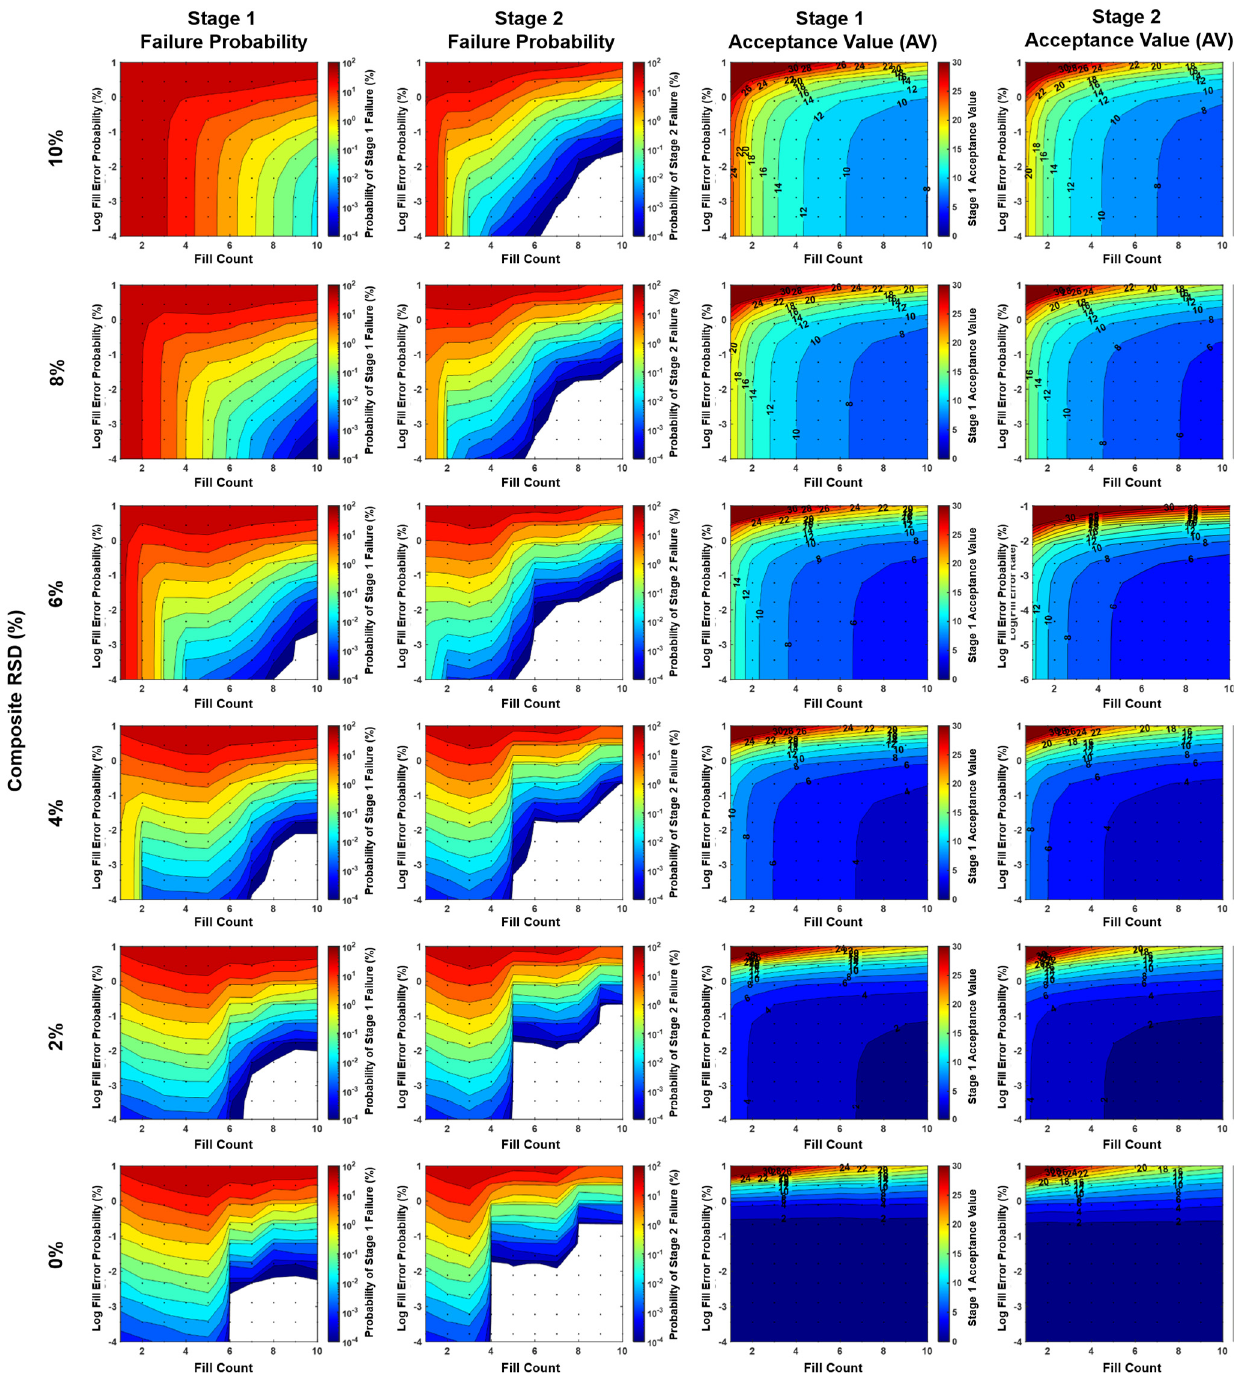
Figure 6. The probability of stage 1 and stage 2 content uniformity batch failure and acceptance values (AV) are modeled as a function of sachet fill count (horizontal axes), fill error probability per mini-tablet filled (vertical axes), and composite RSD (rows). Tabulated values may be found in Supplementary Materials Section S2.3.